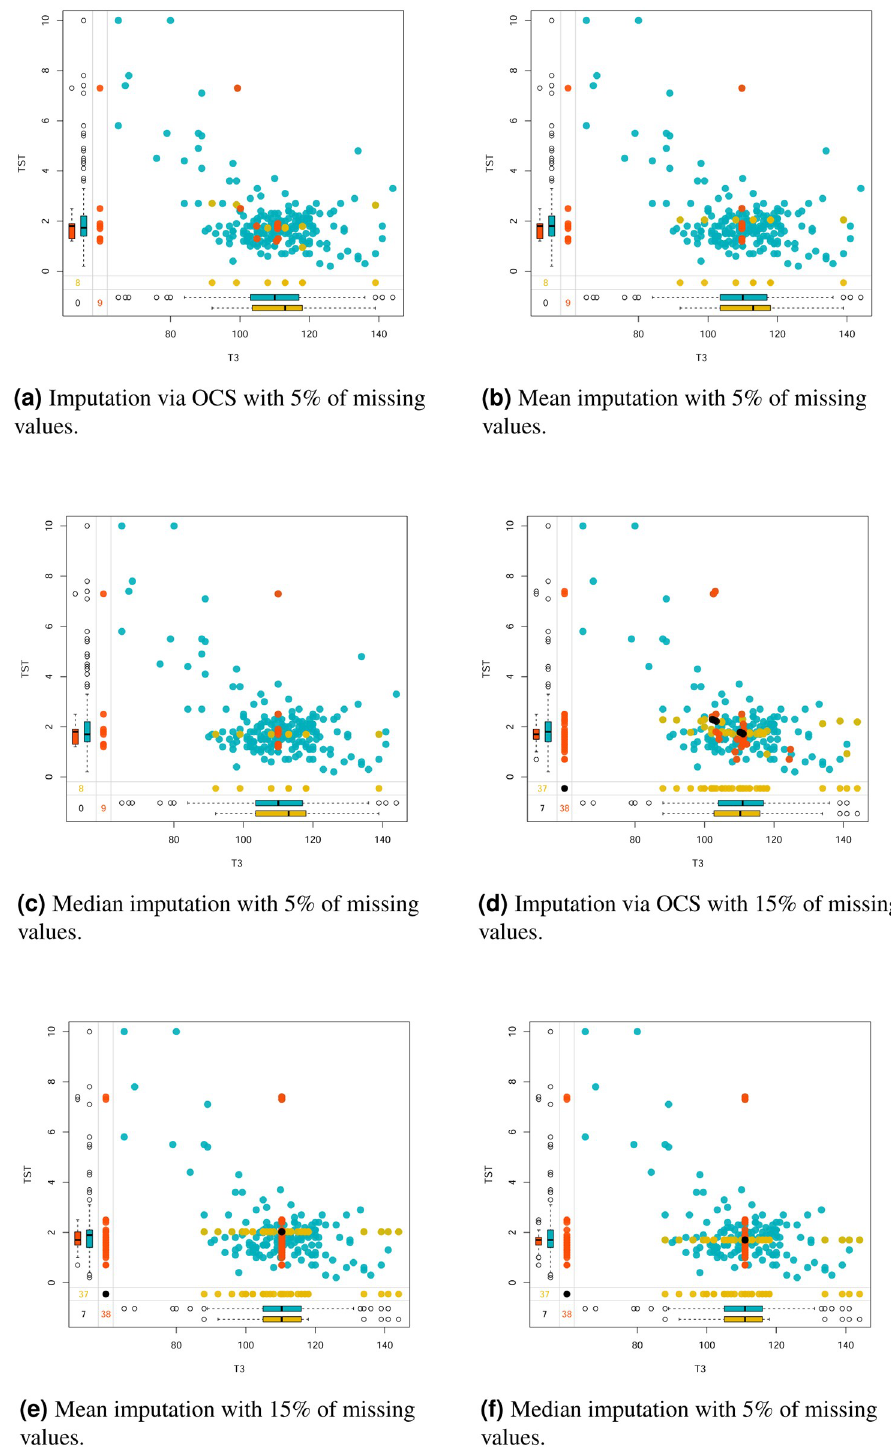
Fig 10. Scatter plots and boxplots for the Thyroid Gland dataset considering the different imputation methods. ( a ) Imputation via OCS with 5% of missing values. ( b ) Mean imputation with 5% of missing values. ( c ) Median imputation with 5% of missing values. ( d ) Imputation via OCS with 15% of missing values. ( e ) Mean imputation with 15% of missing values. ( f ) Median imputation with 5% of missing values.